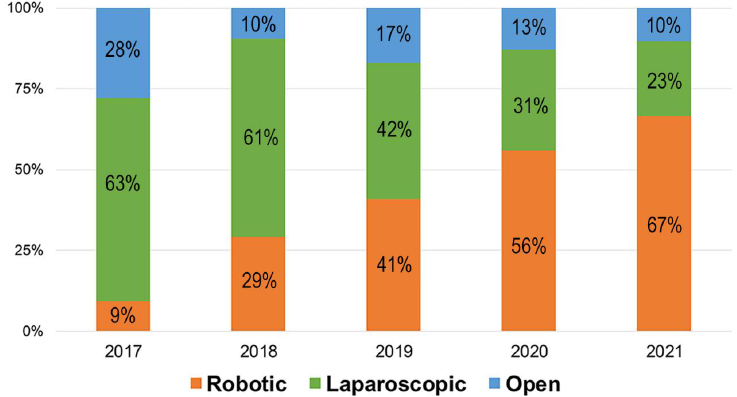
Figure 2. Proportion of radical nephroureterectomy stratified by the surgical approach.